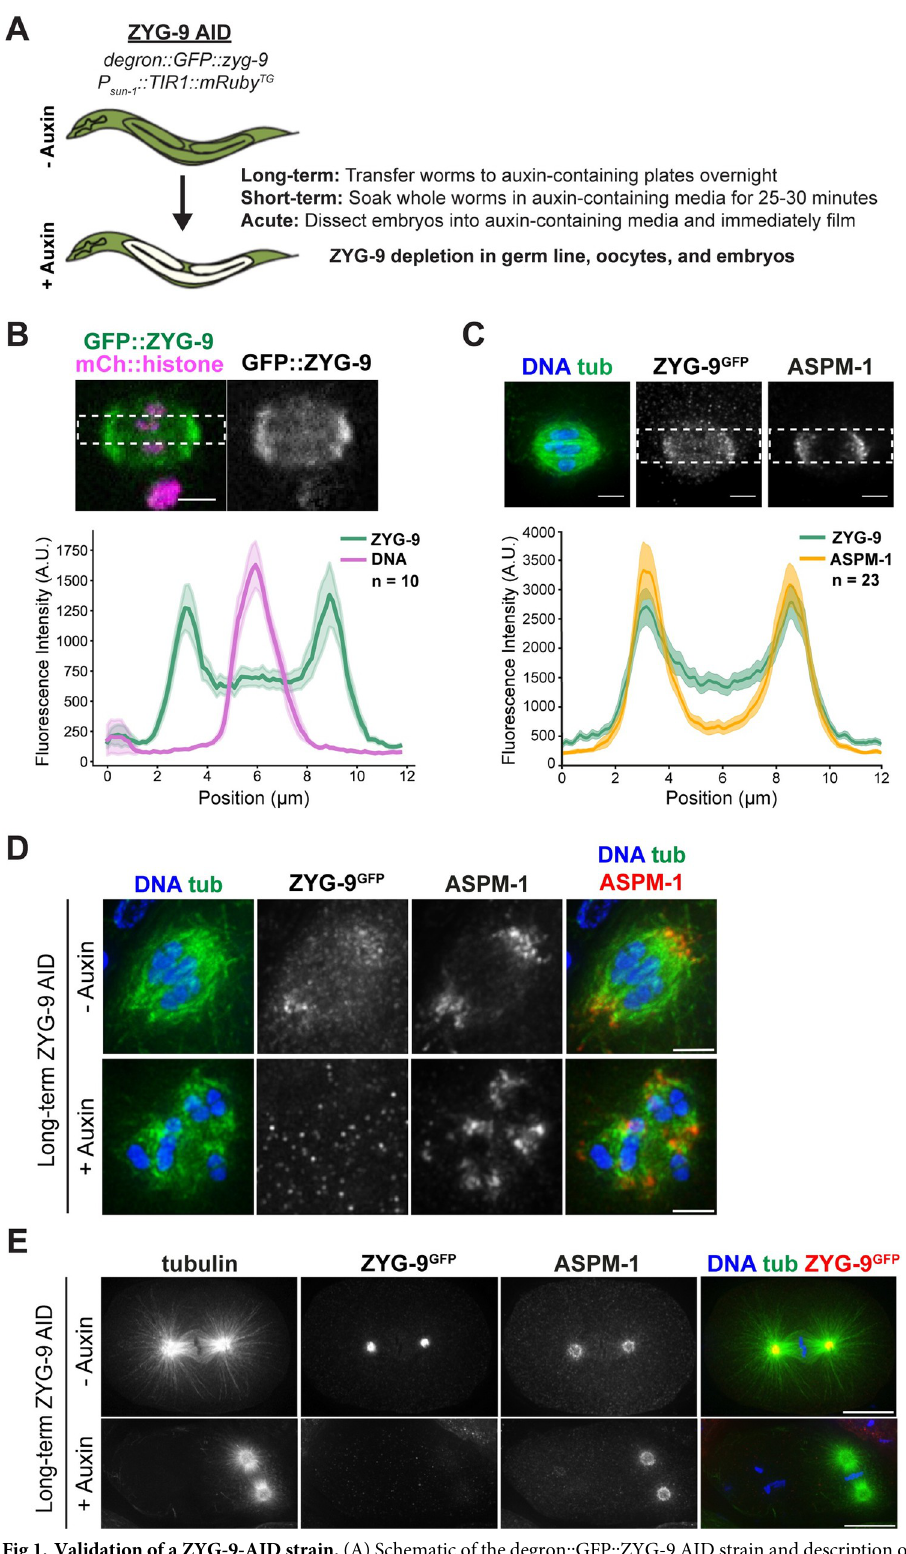
Fig 1. Validation of a ZYG-9-AID strain. (A) Schematic of the degron::GFP::ZYG-9 AID strain and description of auxin treatment lengths. ZYG-9 is tagged at the endogenous locus and the TIR1 transgene is expressed from